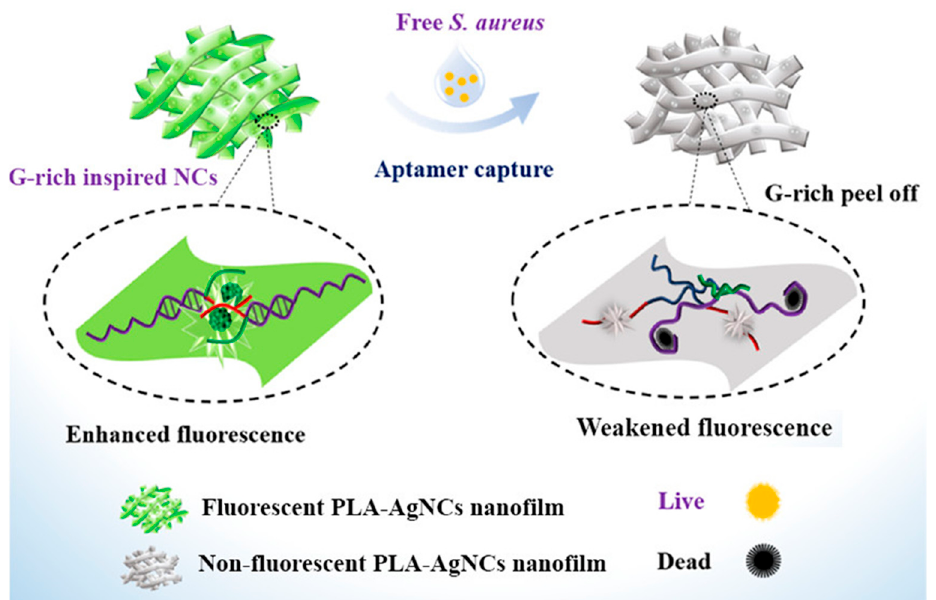
Figure 15. Mechanism of aptamer-enhanced fluorescence and antibacterial activity of DNA-AgNCs in electrospinning film. Reproduced with permission from Ref. [85]. Copyright 2021, American Chemical Society.